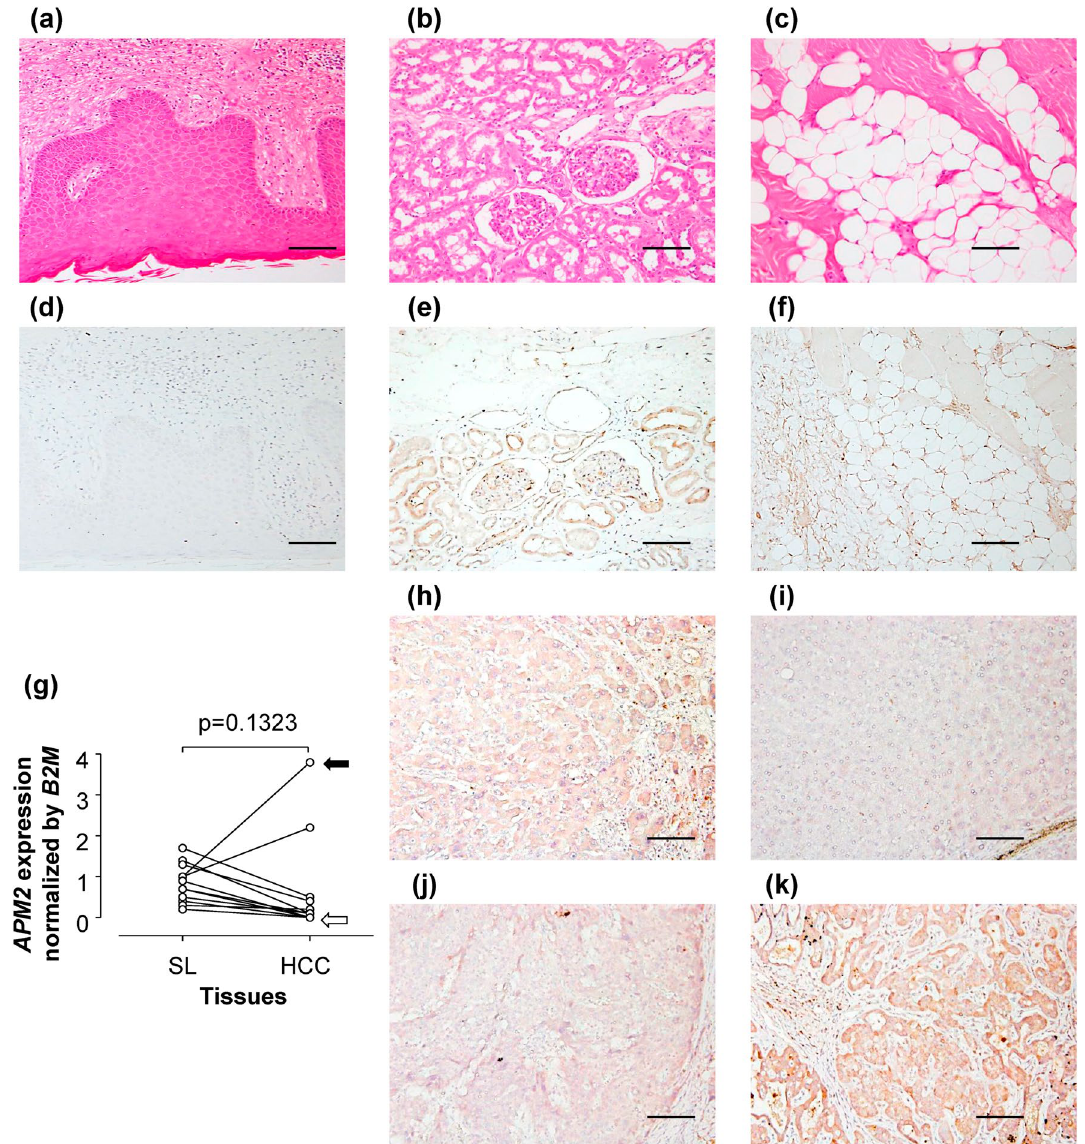
Figure 1. Expression of APM2 in various tissues. ( a – c ) Hematoxylin and eosin staining of ( a ) normal skin tissue, ( b ) normal kidney tissue, and ( c ) normal adipose tissue. ( d – f ) Immunohistochemical staining of APM2 of ( d ) normal skin tissue, ( e ) normal kidney tissue, and ( f ) normal adipose tissue. The scale bar represents 100 µm. ( g – k ) The level of APM2 in the liver and hepatocellular carcinoma (HCC) from patients who had received no chemotherapy. ( g ) Expression of APM2 gene in the surrounding liver tissue (SL) and HCC in 12 patients. B2M, β2 microglobulin. The black arrow indicates that the case showed an increased level of APM2 gene expression in the tumor, whereas the white arrow indicates that the case showed no significant changes between the tumor and surrounding area. The significance of APM2 gene expression was examined using the paired t -test. ( h – k ) Representative immunohistochemical staining of APM2 in the liver tissues ( h , i ) and the HCC tissues ( j , k ) of each case. The scale bar represents 100 patients with partial response (PR group) to treatment, those with a stable disease (SD group), and those with a progressive disease (PD group) after CDDP administration. Representative computed tomographic images are shown in Fig. 5a–f. Positively stained areas were quantitatively analyzed in several cases in each group (4, 6, and 3 in the PR, SD, and PD groups, respectively) (Fig. 5g–s), the results of which indicate a significantly higher APM2 expression in the tumor tissue among patients in the PD group than in those of the PR and SD groups ( p < 0.001) (Fig. 5s). In addition, a significantly higher level in the surrounding tissue of patients in the PD group than in that of patients in the PR group ( p < 0.01) was noted. To determine whether ERCC6L expression was correlated with both APM2